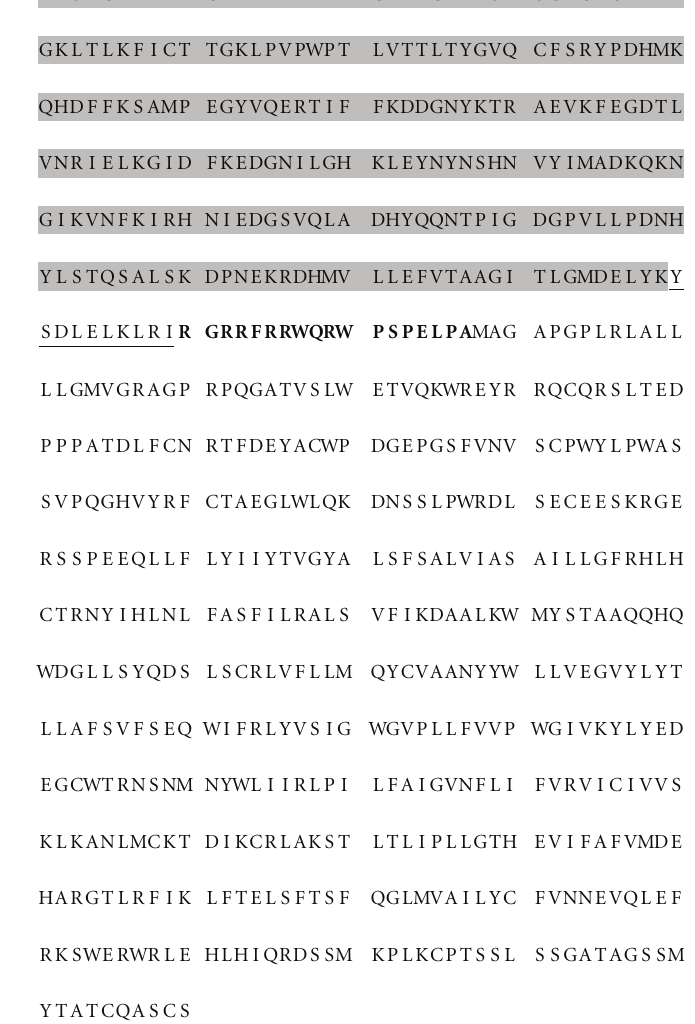
Figure 1: Deduced amino acid sequence of the GFP-GLP-1 receptor. GFP (shaded box); MCS (underlined); 5 (cid:4) -untranslated region of the clone hGLPR-6(20) (bold); human GLP-1 receptor